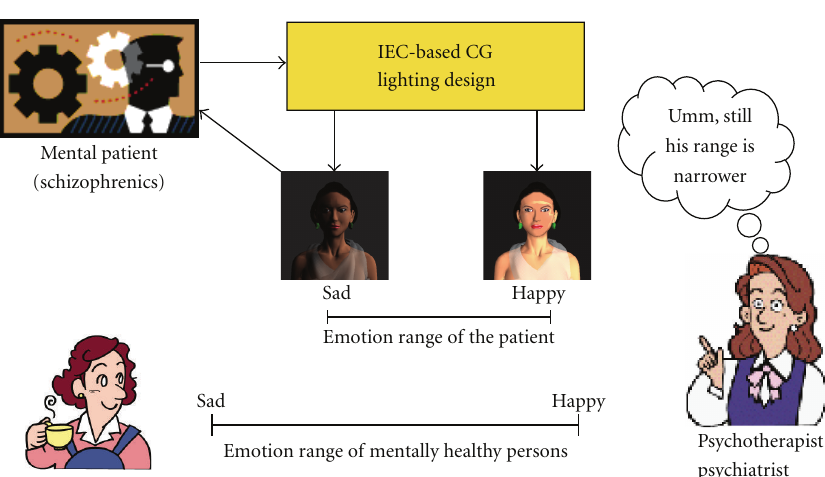
Figure 3: Mental-state measurement with IEC-based design support system. A subject designs impressions, such as happy and sad , using an IEC-based design support system, and mental experts compare his/her impression range of happy - sad with that of mentally healthy